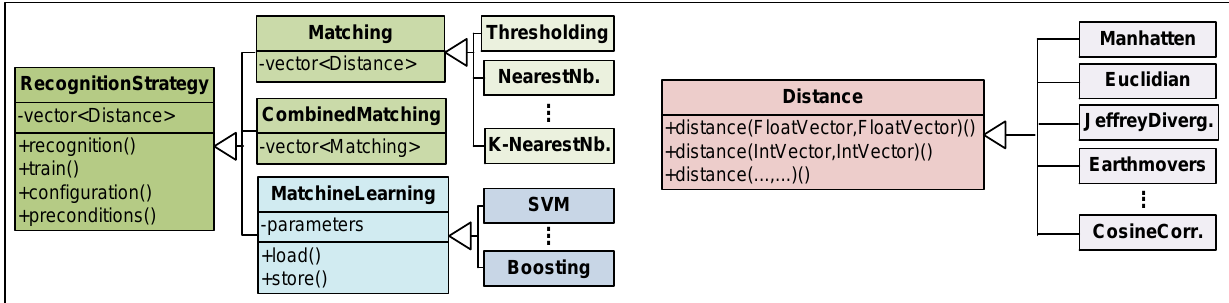
Figure 8. Class diagram of recognition